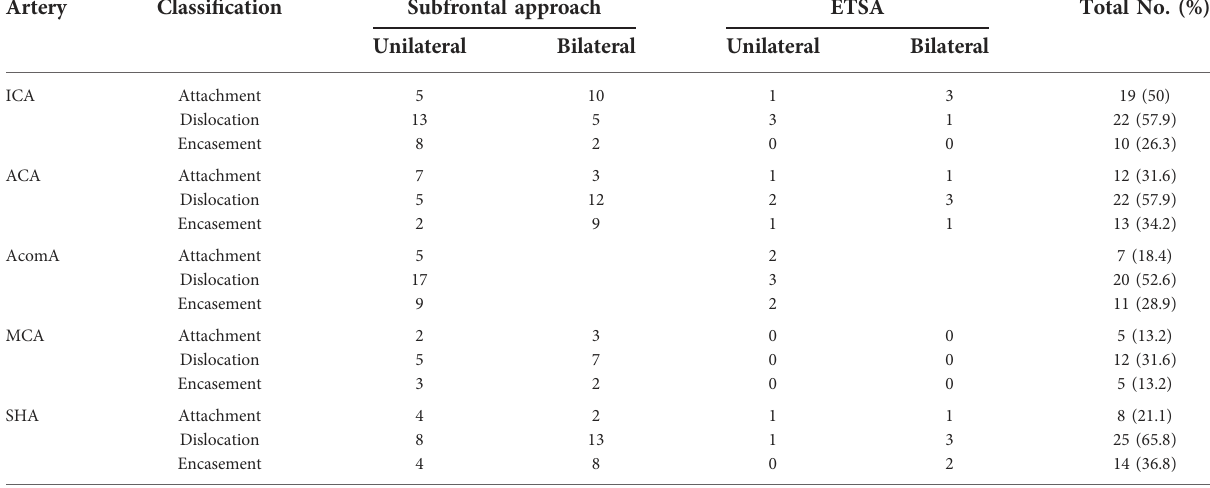
TABLE 2 The relationship between the giant TSMs and cerebral arteries.